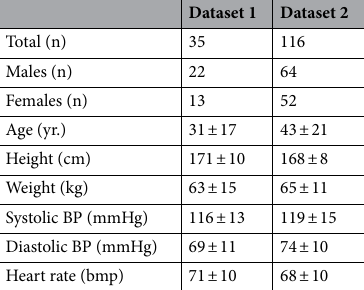
the data acquisition, of which 35 provided the radial flow wave and pressure wave, and 116, the radial arterial pressure wave and cfPTT. The volunteers were all healthy adults. The database of virtual healthy subjects’ pressure wave was used to observe the influence of arterial param- eters on the backward wave. The database uses a validated one-dimension model with parameters varied within the healthy range to generate 3325 sets of pressure and flow waves of virtual healthy adult subjects. There are seven parameters including elastic arterial PWV ( V e ), muscular arterial PWV ( V m ), elastic arterial diameter ( D e ), muscular arterial diameter ( D m ), heart rate (HR), stroke volume (SV), and peripheral vascular resistance (R) of 55 arteries, varying in different levels, which cause a change in the wave 27 . Wave decomposition analysis. As shown in the Fig. 1, the block diagram of the time delay estimation methodology is given. A double triangular wave can be fitted to estimate the flow wave from the radial pressure wave, as shown in Fig. 2. Then the fitted double triangular wave is used to replace the flow wave Q m ( t ) in Eqs. (3) and (4). Z c is the characteristic impedance of the corresponding artery, and can be calculated from frequency or time domains 28 . Based on previous research, calibration of the flow wave is not required 17 . The pressure wave, P m ( t ) can be directly measured from the radial artery noninvasively. Both blood flow and pressure waves can be regarded as a superposition of forward and backward waves 29,30 . The effect of reflections on the pressure wave and flow wave is opposite. The measured waves, P m ( t ) and Q m ( t ) can be expressed as follows: